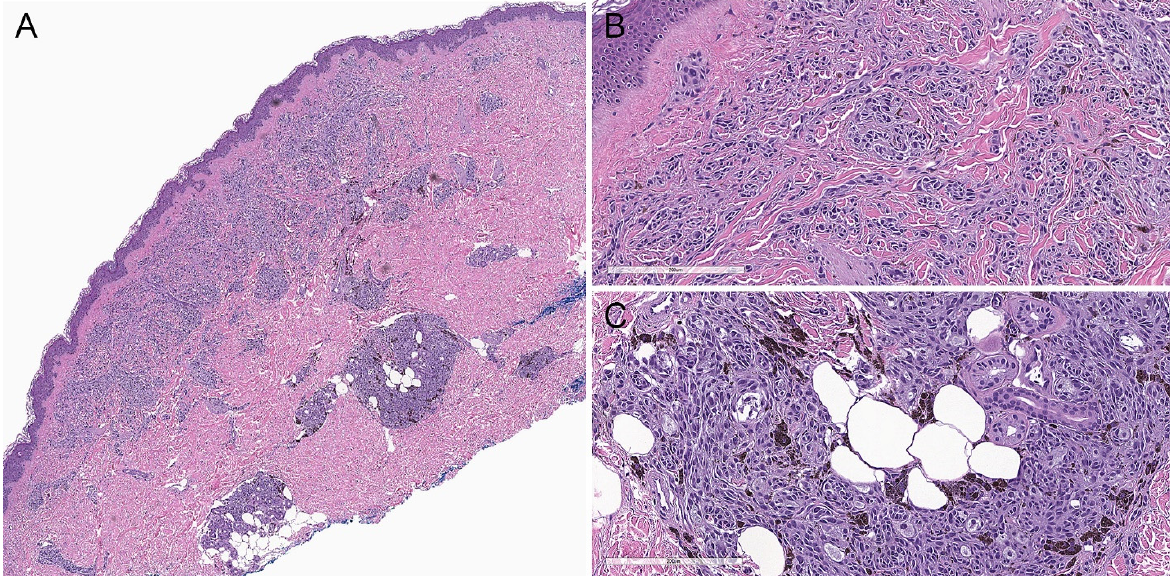
Figure 2. Conventional deep penetrating nevus. ( A ) There is a wedge-shaped proliferation of melanocytes in the dermis and subcutis with an overlying grenz zone (hematoxylin and eosin, 20×). ( B ) Lesional cells are arranged in fascicles, cords, and nests (hematoxylin and eosin, 100×). ( C ) The melanocytes are epithelioid and spindled, with amphophilic cytoplasm and admixed scattered pigmented melanophages (hematoxylin and eosin, 100×).